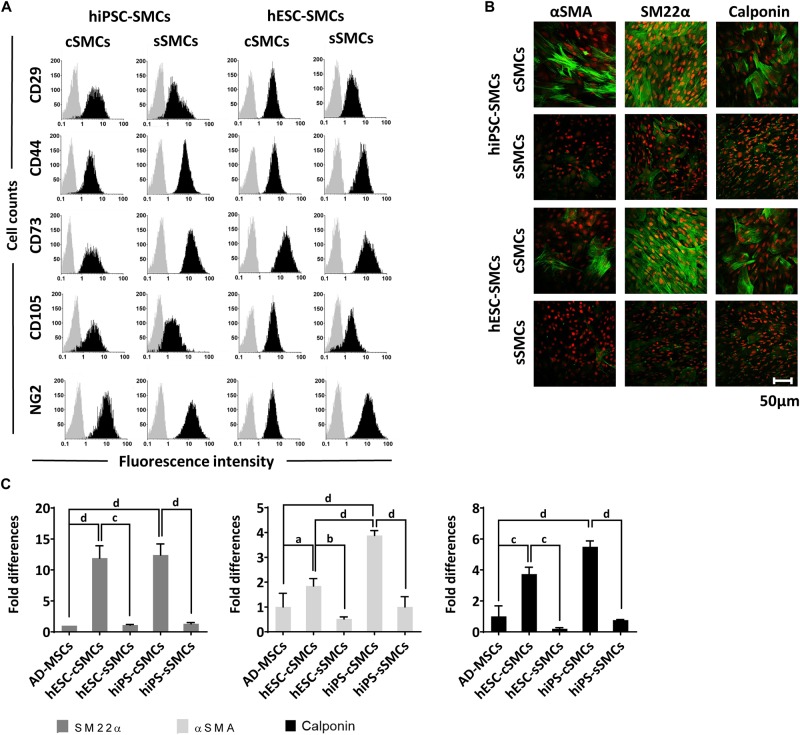
Phenotypic analysis of hPSC-cSMCs and hPSC-sSMCs. (A) The panel shows representative flow cytometry histograms of hiPSC-cSMCs, hiPSC-sSMCs, hESC-cSMCs, and hESC-sSMCs (columns from left to right). The histograms of the samples stained with the isotypic IgGs are shown in light gray, whereas the samples stained with fluorochrome-conjugated antibodies are overlaid in black. Each histogram is a representative of at least three independent experiments. (B) Immunofluorescence analysis performed on hiPSC-cSMCs, hiPSC-sSMCs, hESC-cSMCs, and hESC-sSMCs. Green fluorescence indicates cells positive for αSMA (left column), SM22α (middle column), and Calponin (right column) whereas red indicates nuclei (PI stain). Images were taken on Leica TCS SP5 confocal microscope and they are representative of three independent experiments. Scale bar, 50 μm. (C) Relative numbers of cells expressing SM22α, αSMA and Calponin from AD-MSCs, hESC-cSMCs, hESC-sSMCs, hiPSC-cSMCs, and hiPSC-sSMCs (histograms left, middle and right respectively) are expressed as fold differences based on quantification of the immunofluorescence analysis (B). The means ± SD were calculated from three independent experiments, aP < 0.05, bP < 0.01, cP < 0.001, dP < 0.001.